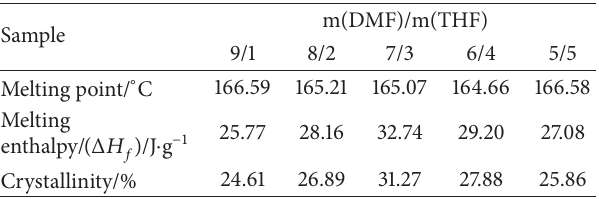
Table 2: The thermal properties and the crystallinity of different solvents ratio PVDF/PEI composite fiber membrane prepared by